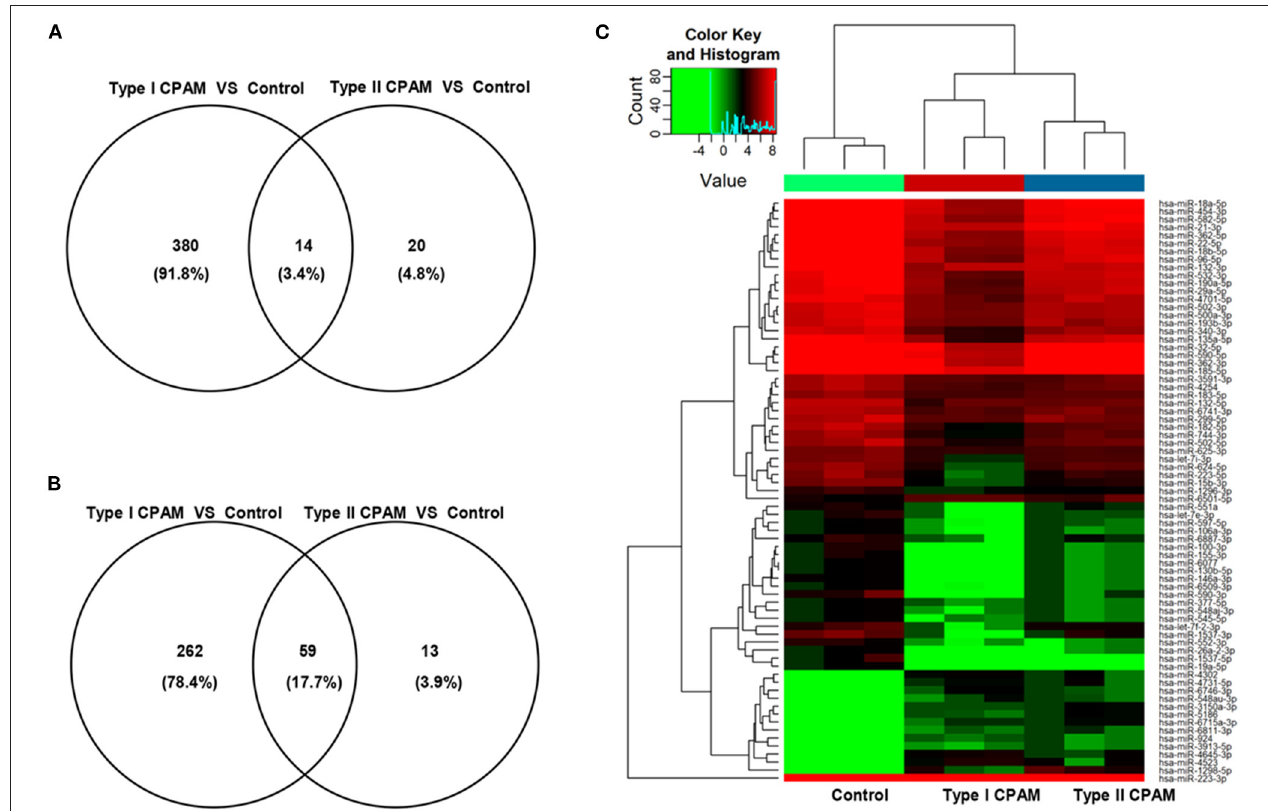
FIGURE 3 | Common differentially expressed miRNAs between type I and type II CPAM compared with control groups. (A,B) Venn diagram of common up- and downregulated differentially expressed miRNAs between type I and type II CPAM compared with control groups and (C) Hierarchical clustering to present the common differentially expressed miRNAs between type I CPAM or type II CPAM groups and control